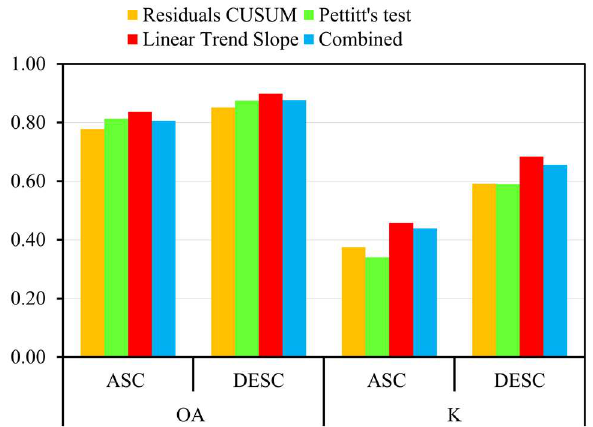
Figure 9 . OA and K values resulting from different forest harvesting classifications in respect to